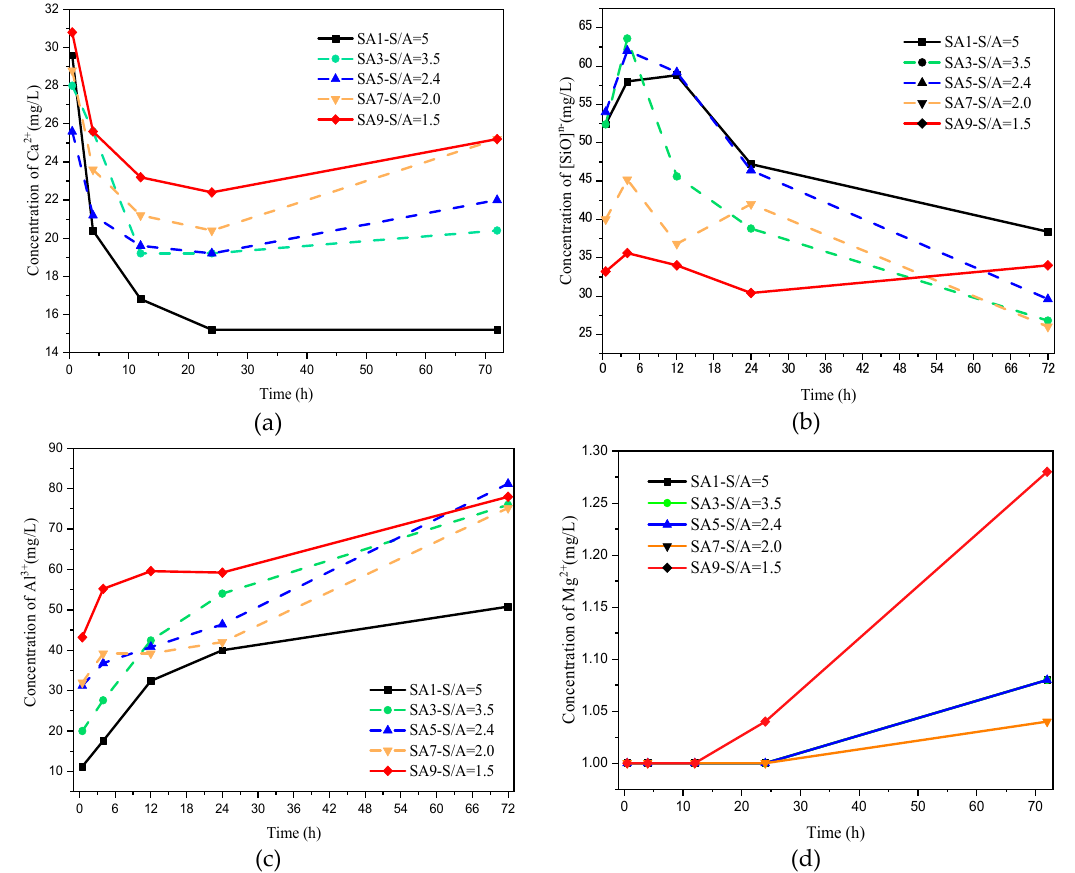
Figure 7. Early ion dissolution characteristics of slag with different S/A in alkaline environment: ( a ) ion dissolution characteristic of Ca 2+ ; ( b ) ion dissolution characteristic of [SiO] n − ; ( c ) ion dissolution characteristic of Al 3+ ; ( d ) ion dissolution characteristic of Mg 2+ .